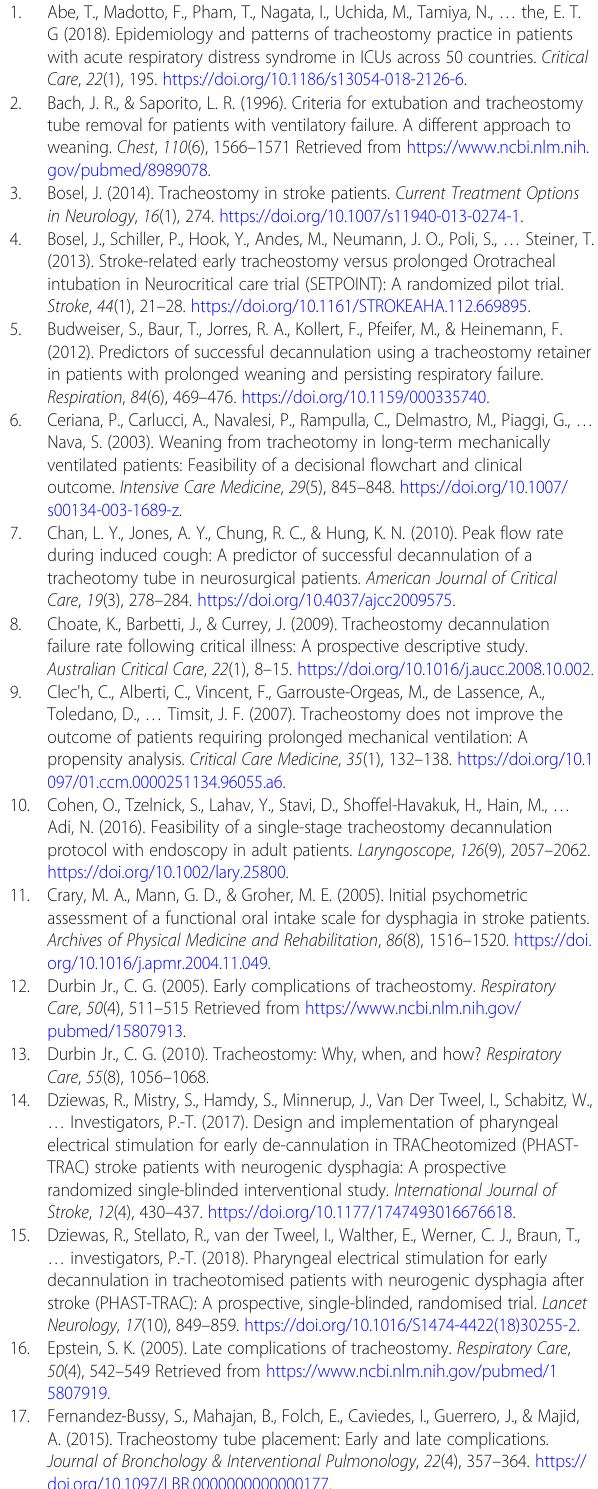
Additional file 2: Supplement Figure 2. Receiver operator characteristics curve: successful decannulation during course of stay depending on the initial score of the SESETD. Area under the curve: 0.678 [95%-CI: 0.623 – 0.732]; Sensitivity: 0.64; Specificity: 0.66; Positive Predictive Value: 0.74; Negative Predictive Value: